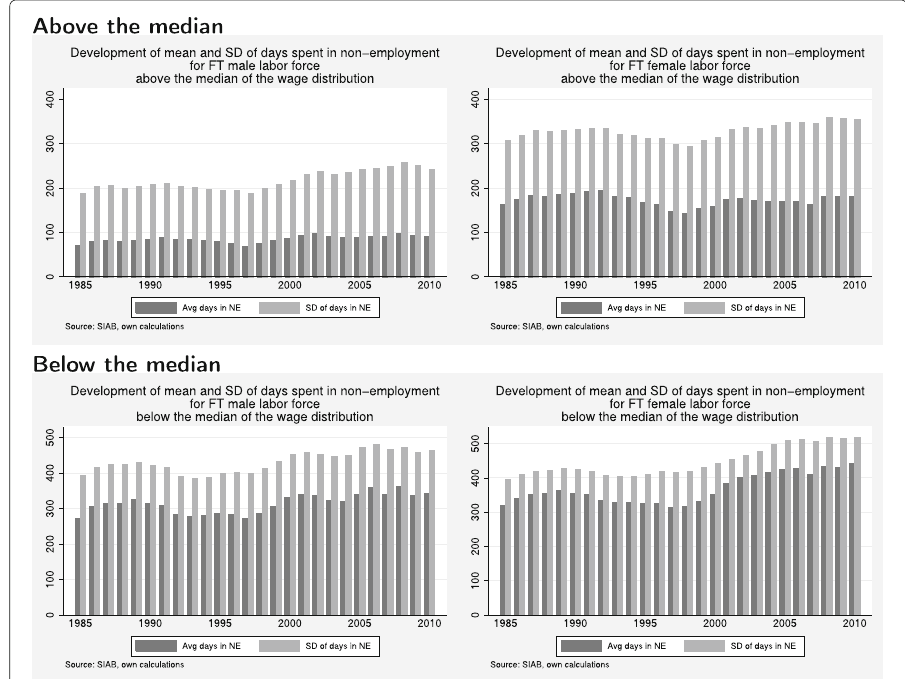
Fig. 6 Days spent in non-employment during the last 5 years (full-timers aged 25-60